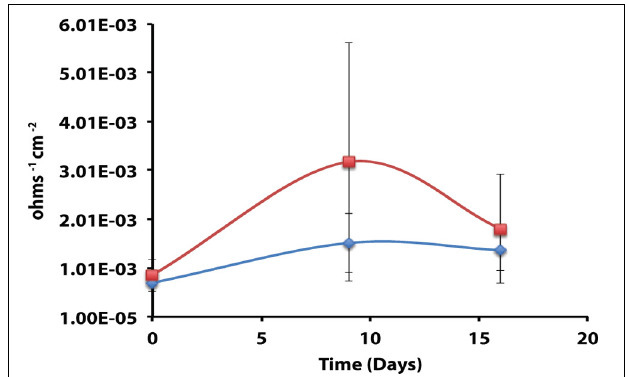
FIGURE 4 | Instantaneous corrosion rates (1/ Rp ) for lactate-amended pure cultures of Desulfovibrio sp . strain G11 ( ) and uninoculated basal medium controls amended with 20mM lactate ( ) (standard deviation incubations n = 3, medium controls n = 2).